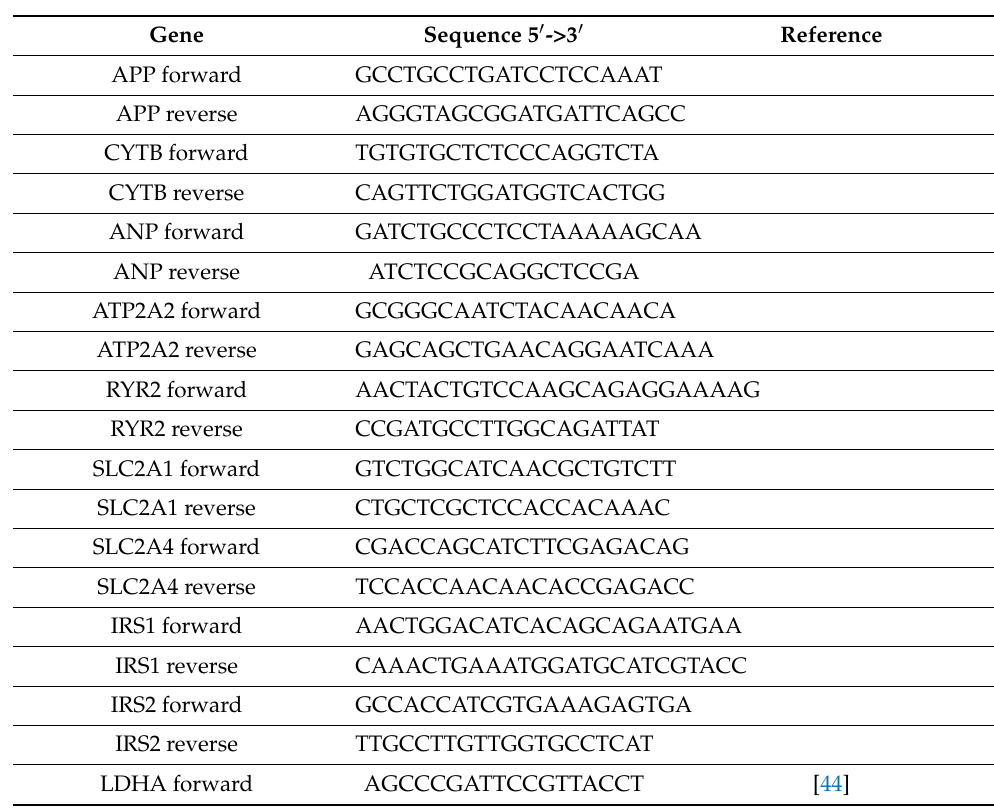
Table A2. Primer sequences used in